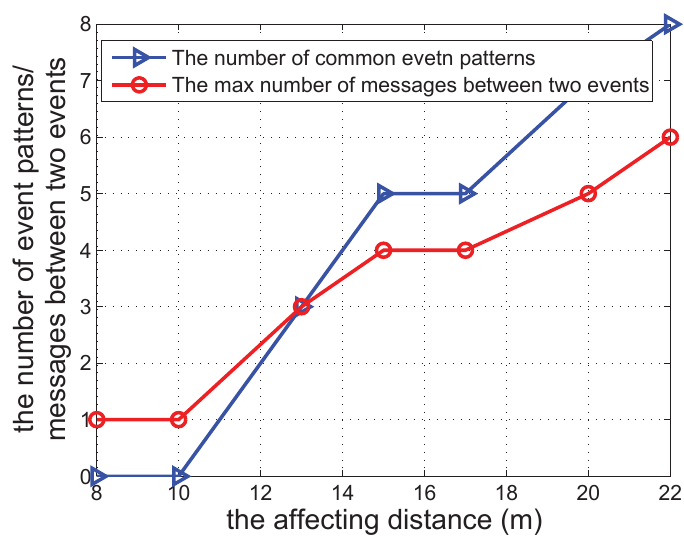
Figure 14. The number of common event patterns/the max number of messages between two events vs. the affecting